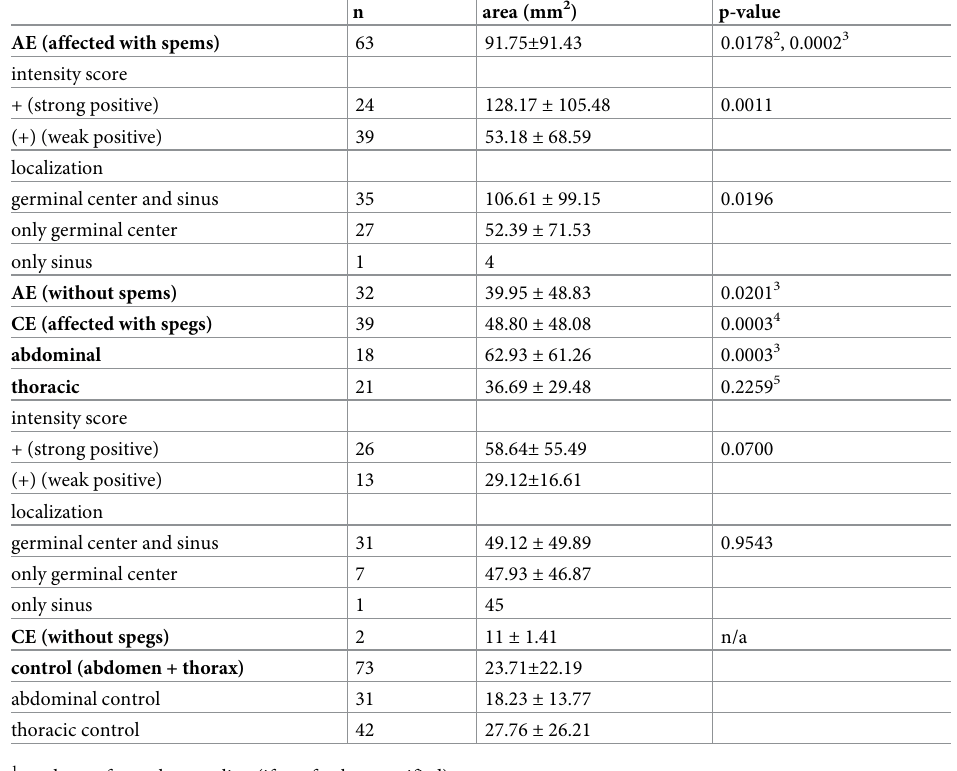
Table 3. Results of regional lymph node measurements of patients with alveolar or cystic echinococcosis and of control group without